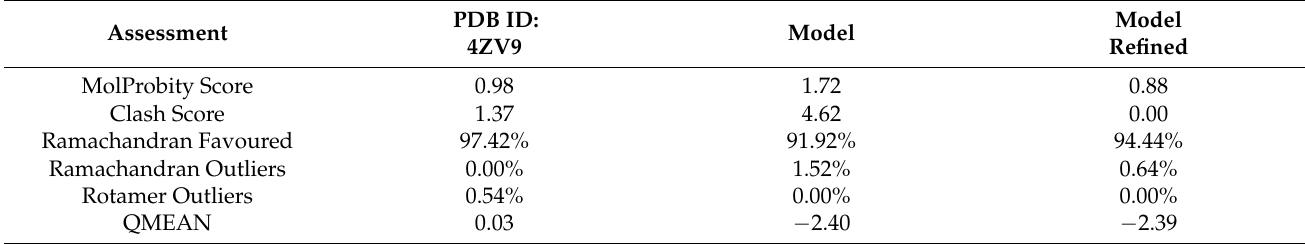
Figure 7. Pairwise sequence alignment employed for the comparative modeling of the J. curcas esterase based on the structure of the uncharacterized protein from E. coli O157:H7 str. Sakai (PDB ID: 4ZV9). The sequences have 37% identity and 89% coverage. The active site residues — Cys-78, Asp-126, and His-161- are conserved between target and template. Black filled positions in the sequence alignment represent identical residues. Points represent gaps. Table 5. Evaluation of J. curcas esterase model and its template.